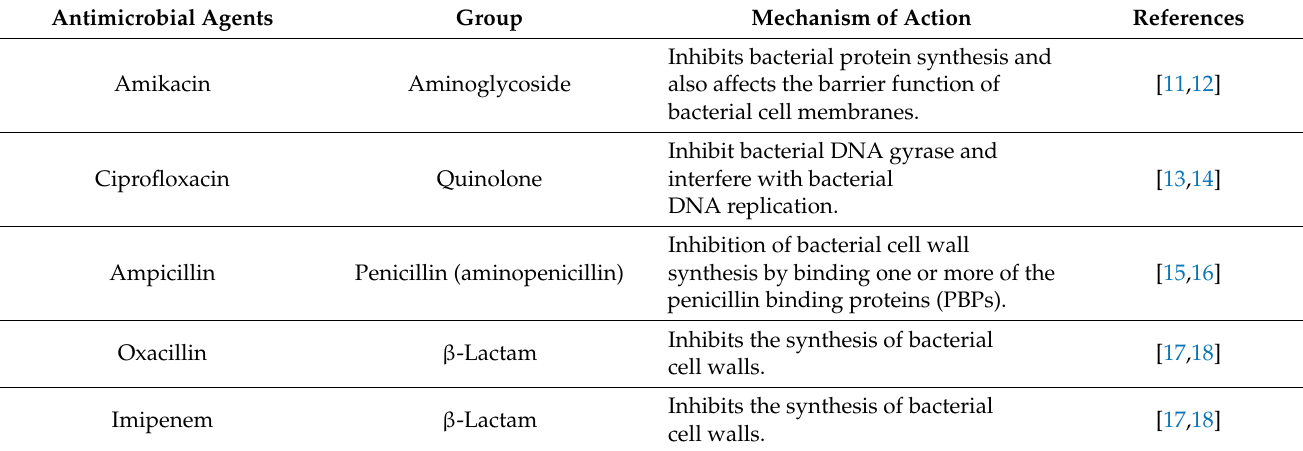
Inhibits bacterial protein synthesis and also affects the barrier function of bacterial cell membranes. Inhibit bacterial DNA gyrase and interfere with bacterial DNA replication. Inhibition of bacterial cell wall synthesis by binding one or more of the penicillin binding proteins (PBPs). Inhibits the synthesis of bacterial cell walls. Inhibits the synthesis of bacterial cell